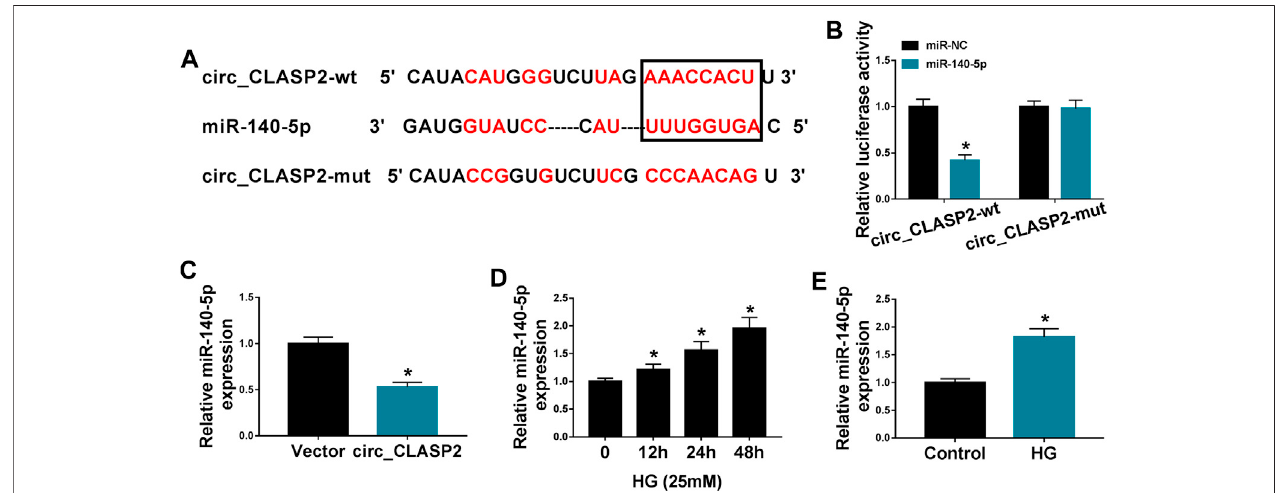
FIGURE 3 | Circ_CLASP2 directly interacted with miR-140-5p in HUVECs. (A) Schematic of the complementary sequence for miR-140-5p within circ_CLASP2 identi fi ed by the starBase v.3 database and the mutant of the seed sequence. (B) Relative luciferase activity was detected in HUVECs cotransfected with circ_CLASP2wild-typereporter(circ_CLASP2-wt)orcirc_CLASP2mutant-typereporter(circ_CLASP2-mut)andmiR-140-5pmimicormiR-NCmimic. (C) MiR-140-5p expression was evaluated by qRT-PCR in HUVECs transfected with Vector or circ_CLASP2. Vector: negative control vector, circ_CLASP2: circ_CLASP2 overexpression vector. (D,E) MiR-140-5p expression was tested by qRT-PCR in HUVECs after HG treatment. n (cid:2) 3 independent biological replicates; data were presented as mean ± SD; * p < 0.05 by a two-tailed Student ’ s t -test or ANOVA followed by Tukey – Kramer post hoc